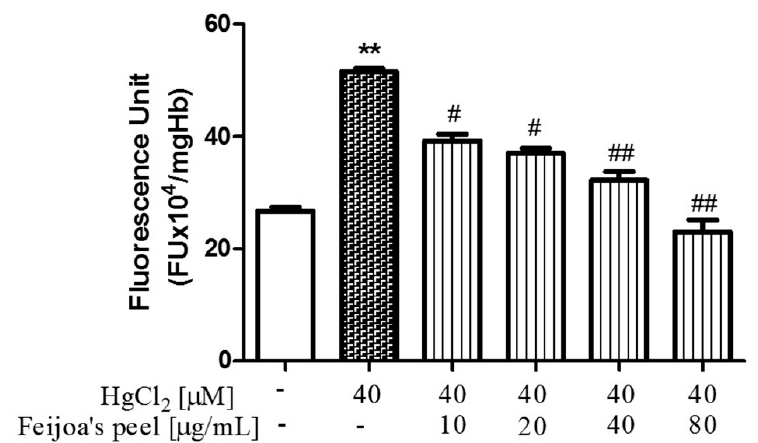
Figure 3. Feijoa peel extract protects against Hg-induced reactive oxygen species (ROS) production in red blood cells (RBC). Cells were treated with 40 µM HgCl 2 for 4 h in the presence of increasing concentrations of extract. ROS production was determined by fluorescence unit means of the dichlofluorescein (DCF) probe. Data are the means ± SEM ( n = 9). Statistical significance was calculated with one-way ANOVA followed by Tukey’s test. ** ( p < 0.05) indicates a significant difference from cells lacking HgCl 2 treatment. # ( p < 0.05) and ## ( p < 0.01) indicate significant differences from cells lacking Feijoa extract treatment.